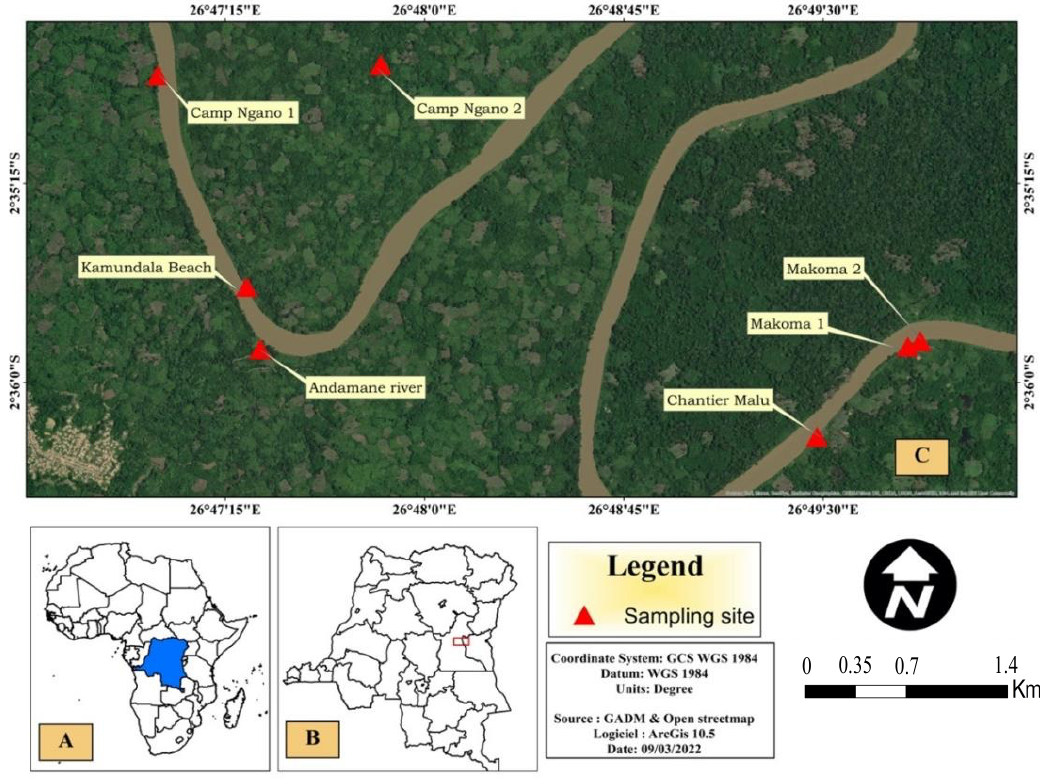
Figure 1. Study area. ( A ) DRC in Africa, ( B ) sampling site (red rectangle) in Maniema Province (DRC), ( C ) Sediment and/or soil sampling sites along Ulindi River and one of its tributaries (Camp Ngano 2).